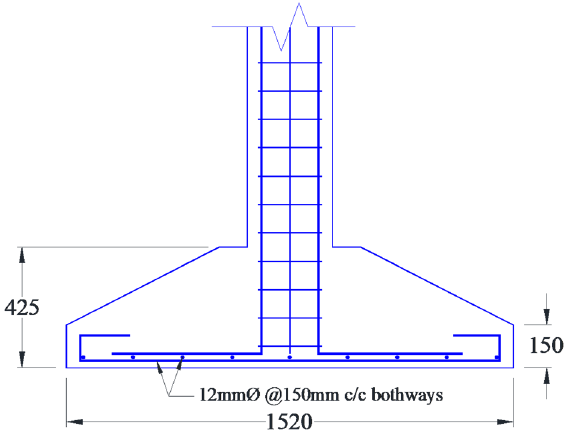
Figure 4. Typical arrangement of isolated footing. Table 1. Geometric and material properties used for finite element modeling.